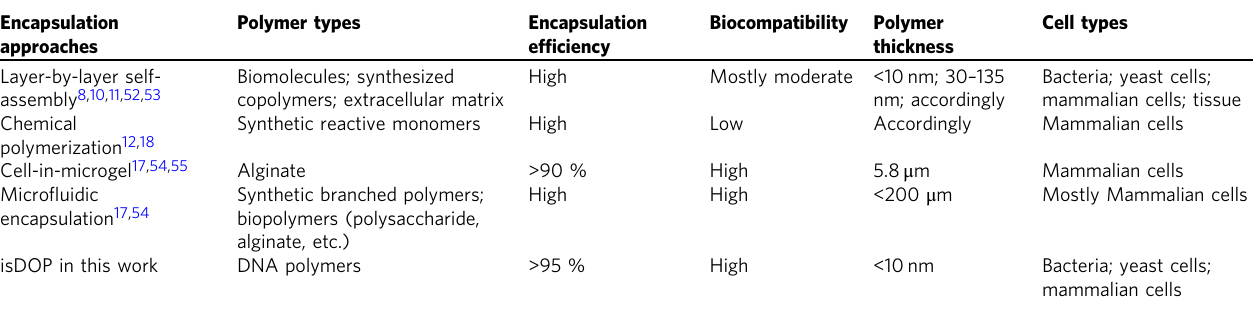
Table 1 A comparison of the different approaches for encapsulating cells in